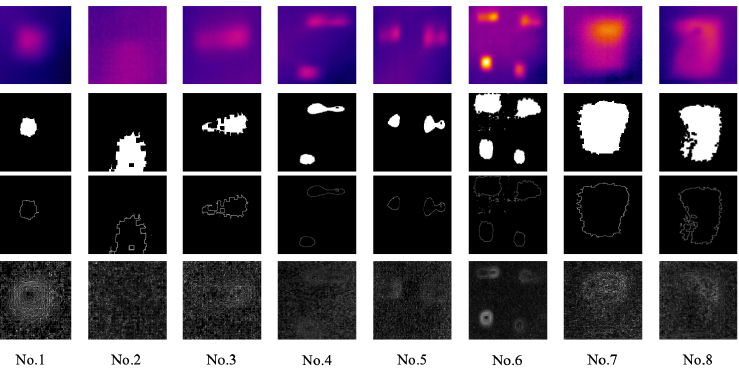
Figure 6. Calculating results in each step of the eight